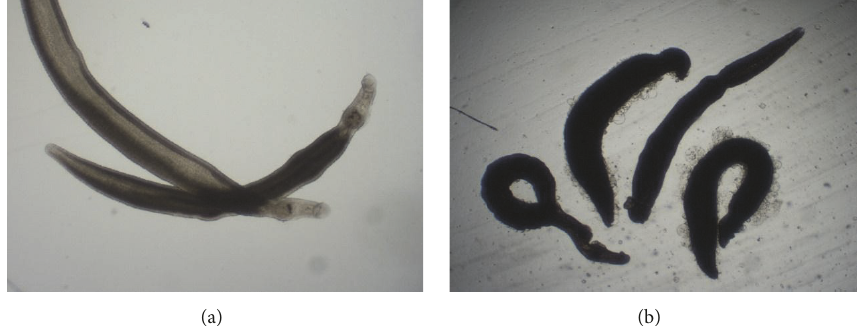
Figure 6: Examples of adult S. mansoni males after exposure to 1.25 𝜇 g/mL of E. ivorense methanol bark extract fractions. (a) Control worms (each worm is approximately 500 to 700 𝜇 m long); (b) damaged worms in the presence of the 50% v/v methanol fraction after 24 h. Note the marked darkening and the damage (blebbing) to the tegumental